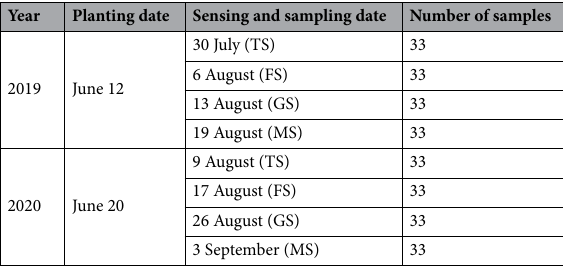
Table 1. Description of